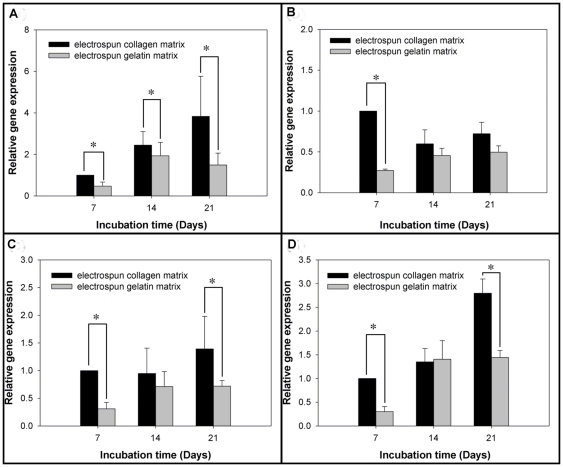
Matrices regulate the bone-associated genes expressed by MG63 osteoblast-like cells.Real–time PCR analyses of bone-associated genes expressed by MG63 osteoblast-like cells on various matrix. (A) β-actin levels, (B) type I collagen levels, (C) OPN levels and (D) OCN levels after normalization to 18S ribosomal RNA levels. Data are shown as the fold change relative to the electrospun collagen matrix after 7 days of incubation. On day 7, the cells showed significantly higher expression levels of β-actin, type I collagen, OPN and OCN when grown on EC. And, the expression levels of β-actin, OPN and OCN were significantly higher on day 21 when grown on EC. Data are presented as mean ± SD, n = 4. Statistical analysis was compared between EC and EG. (*) denotes a significant difference (p<0.05).